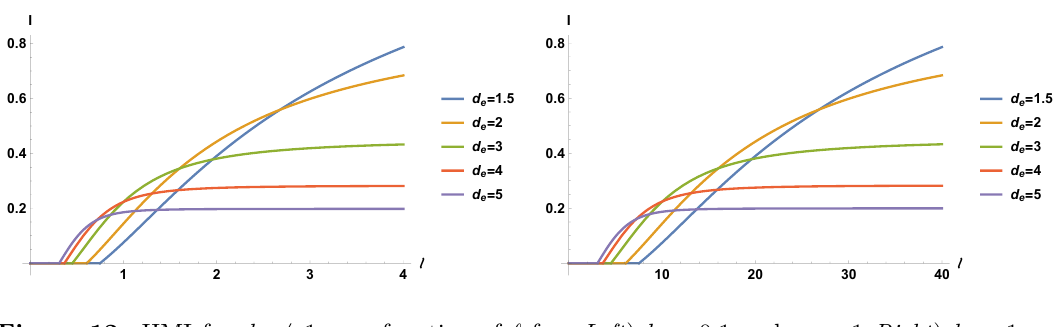
Figure 12 . HMI for d e 6 = 1 as a function of ‘ for: Left ) h = 0 . 1 and r c = 1 Right ) h = 1 and r c = 10 . Here and in the following figures, we renormalized I as